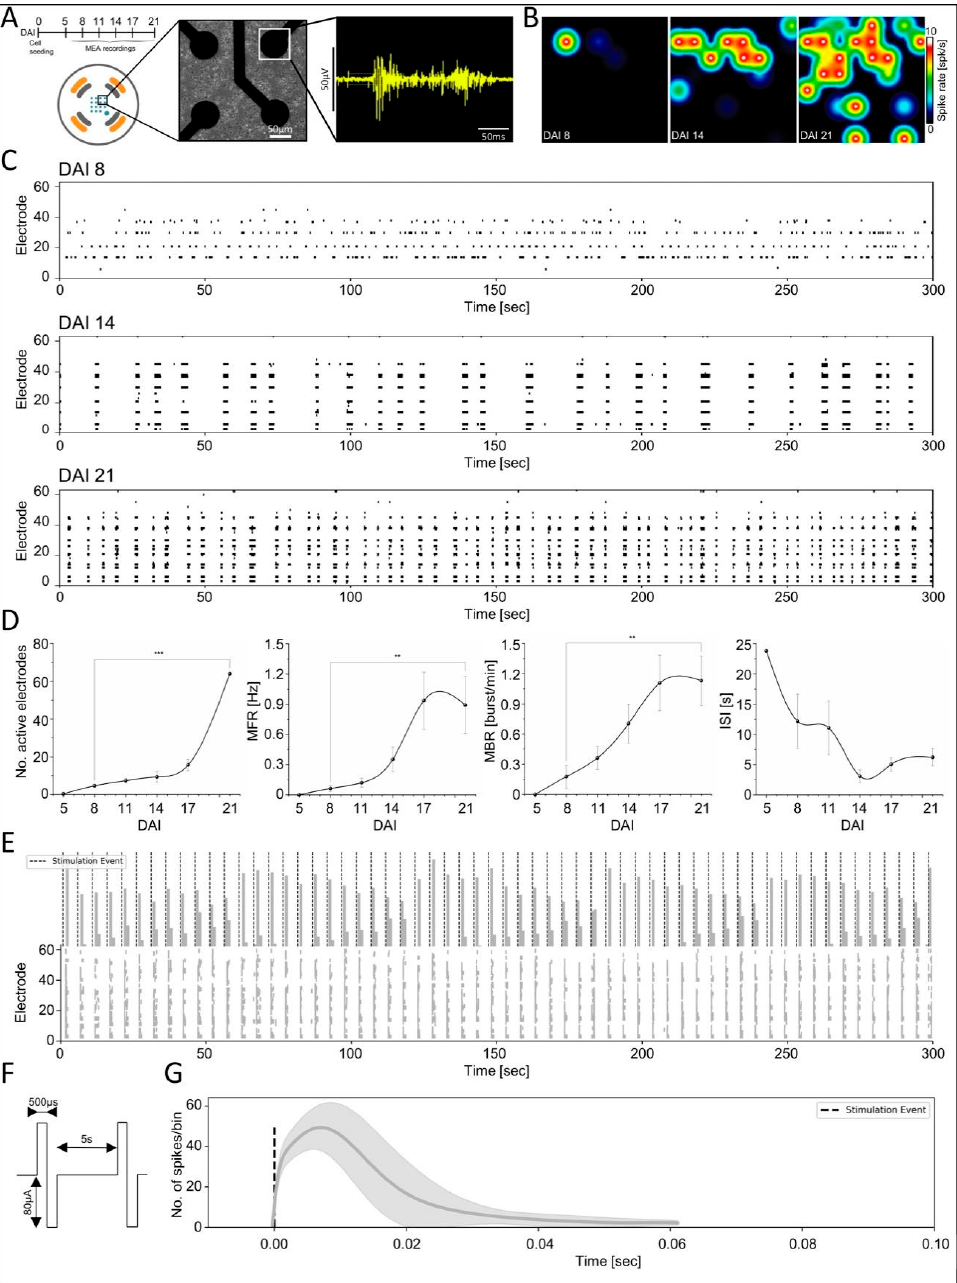
Figure 3. Network-wide characterization of spontaneous and evoked firing features . ( A ) Experimental timeline for extracellular MEA recordings (top). Representative single-well of 8 × 8 microelectrodes array and bright-field image displaying zoom in of 4 electrodes with seeded NPC-iNs neurons (bottom). Representative raw signal trace from a single electrode showing electrophysiological waveform properties as analogous to dissociated primary neuronal activity. ( B ) Activity heatmaps are displaying increased spatiotemporal activity based on spike/s during development. ( C ) Rastergrams of representative firing activity and synchronous bursting patterns from early to mature developmental phases. ( D ) Quantification of activity-dependent changes in parameters during development, including average number of active electrodes, MFR, MBR, and ISI as a function of DAI (*** p < 0.001, ** p < 0.01, ANOVA, N = 3). ( E ) Averaged-firing rate and raster plots of evoked responses following a series of stimulation events as a function of a 5 min time window. ( F ) A biphasic electrical stimulus delivered at 0.2 Hz with 500 µs per phase, and 160 µA peak-to-peak amplitude delivered from pair of electrodes distributed within array. ( G ) Exemplary averaged PSTH computed from all evoked activities corresponding to their stimulating site, with responses lasting 50 ms. Data are presented as mean ±